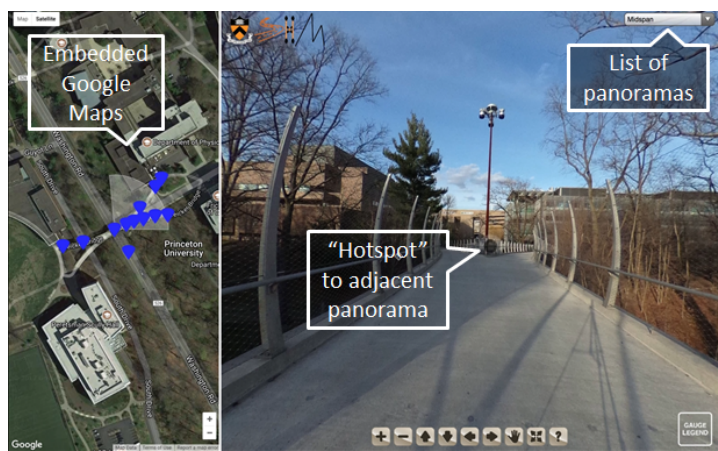
Figure 5. Virtual tour interface illustrating the different types of navigation: (1) embedded Google Maps, (2) “hotspot” connections to adjacent panoramas, and (3) drop-down menu with list of all panoramas of the